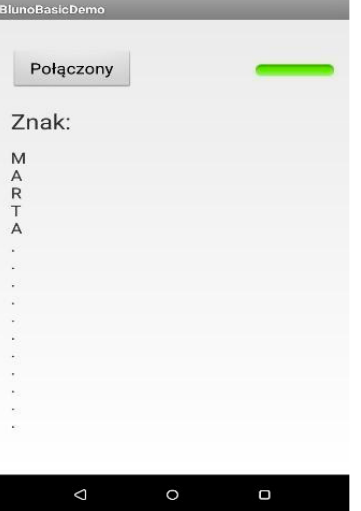
Figure 7. Main screen of the application with a string spelled by the glove. For every letter in a Polish sign language, a set of parameters was determined. Possi- ble combinations are presented in Figure 8. The correct arrangement of the fingers corre- sponds to each letter. For some letters, the state of a single finger does not have to be specified. The stress of the sensors placed on the fingers is important for distinguishing each letter. Each finger’s state can be determined by using three scale measurements. The states are: maximally bent, slightly bent (approx. 90°), and straight. The ranges of the sensor’s data values were evaluated experimentally. The sensors were attached to the glove and pinned to the input of the A/D converter. The Min symbol means that the finger should be straightened, Mid means that the finger should be slightly bent, and Max means that the finger should be bent to the maximum. The symbols “ − ” and “+” in the accelerometer column indicate the need to recognize the hand movements. The figures below show examples of letters C and L in Polish sign language (Figure 8). The position of the fingers defining a given letter is described in Table 1. ( a ) ( b ) Figure 8. Letter C ( a ) and letter L ( b ) in Polish sign language. Table 1. Combinations of parameters that must be satisfied for every letter. Max—finger bent max- imally; Mid—finger slightly bent; Min—straight finger. The accelerometer column shows whether usage of the accelerometer is necessary for the finger. Blue color indicates the letters that are not easily identified (more in Section 4, Discussion). Letter